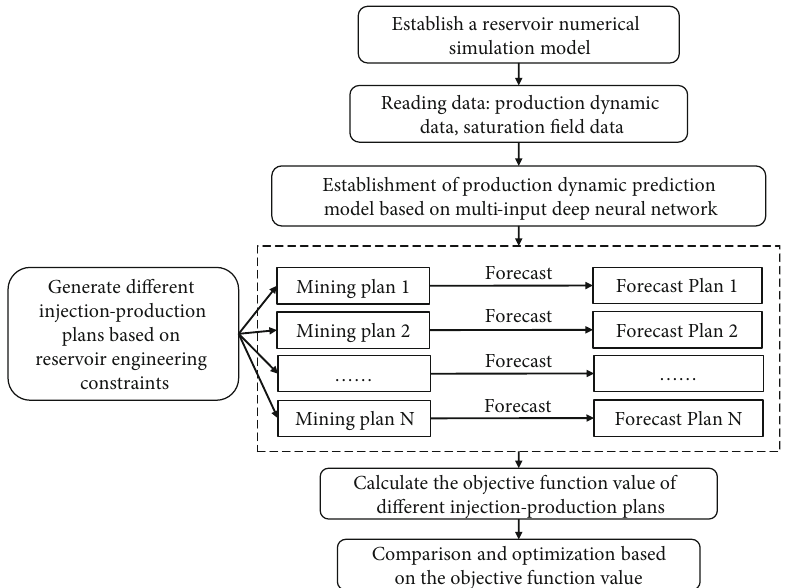
Figure 4: Flow chart of the production dynamic optimization model.